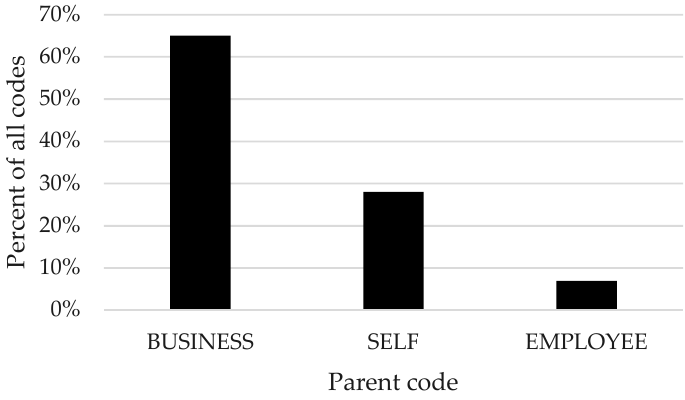
Figure 1. Percent of total codes mentioned by parent code.